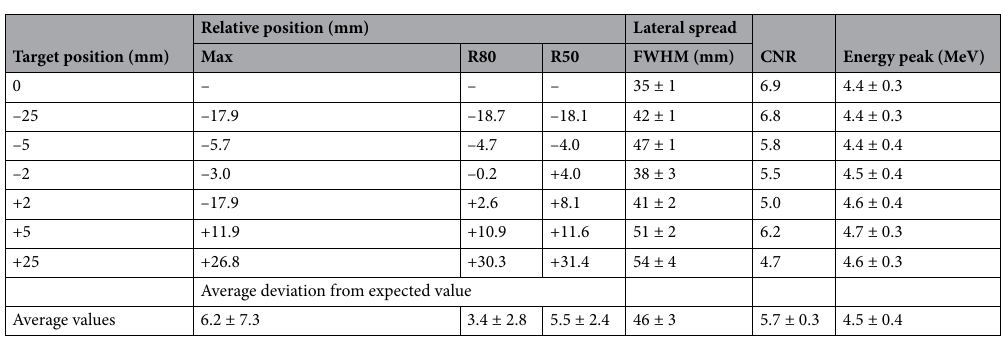
Table 3. Calculated parameters from the images reconstructed with measurements at different target positions. Positions along beam direction are calculated relative to the values obtained at position 0. Average values on the last row are calculated excluding position 0.